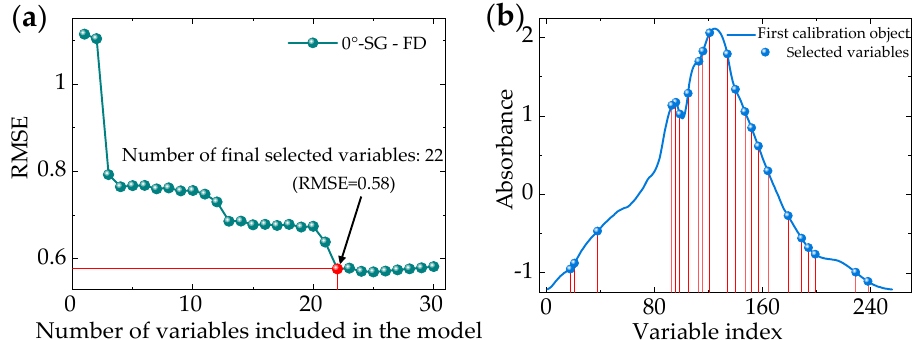
Figure 8. Number of variables in the 0 ◦ incident light model. ( a ) RMSE polyline; ( b ) Selected variables.